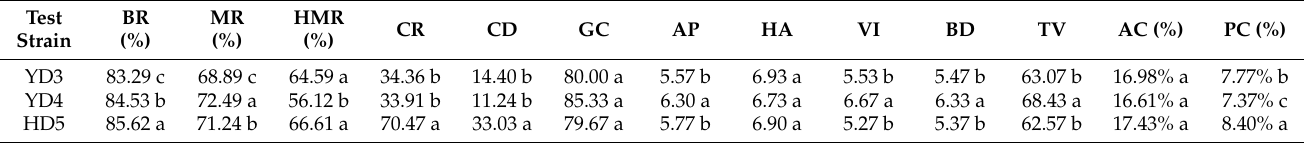
Table 1. Difference analysis of three japonica rice quality